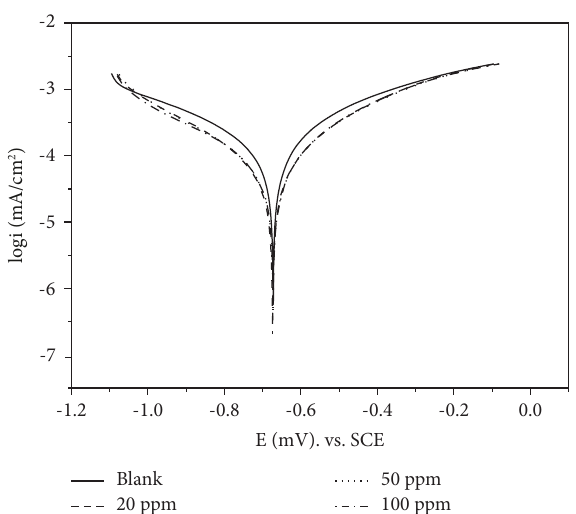
2 SO 4 at diferent